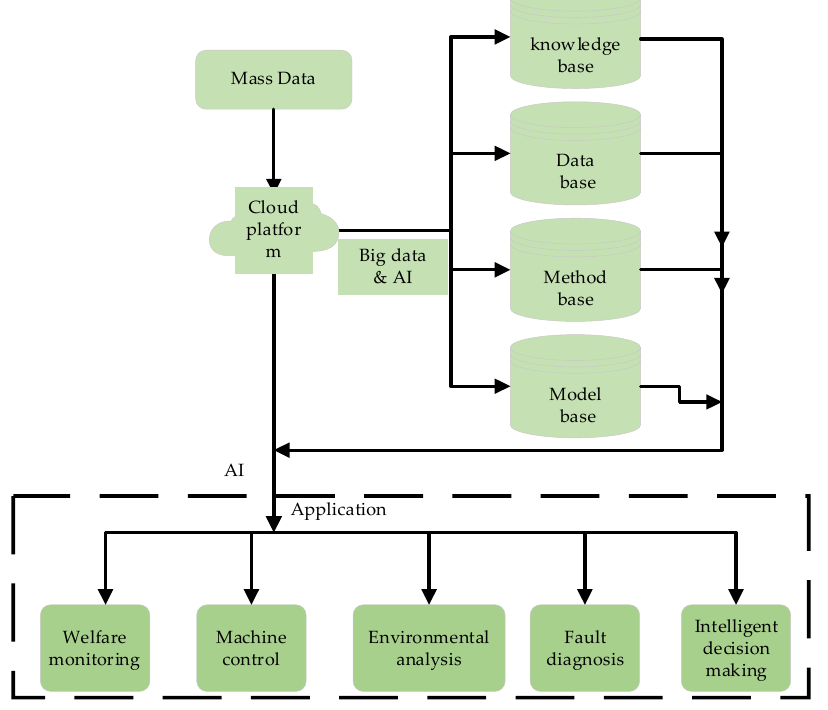
Figure 2. Workflow and application of the intelligent decision cloud